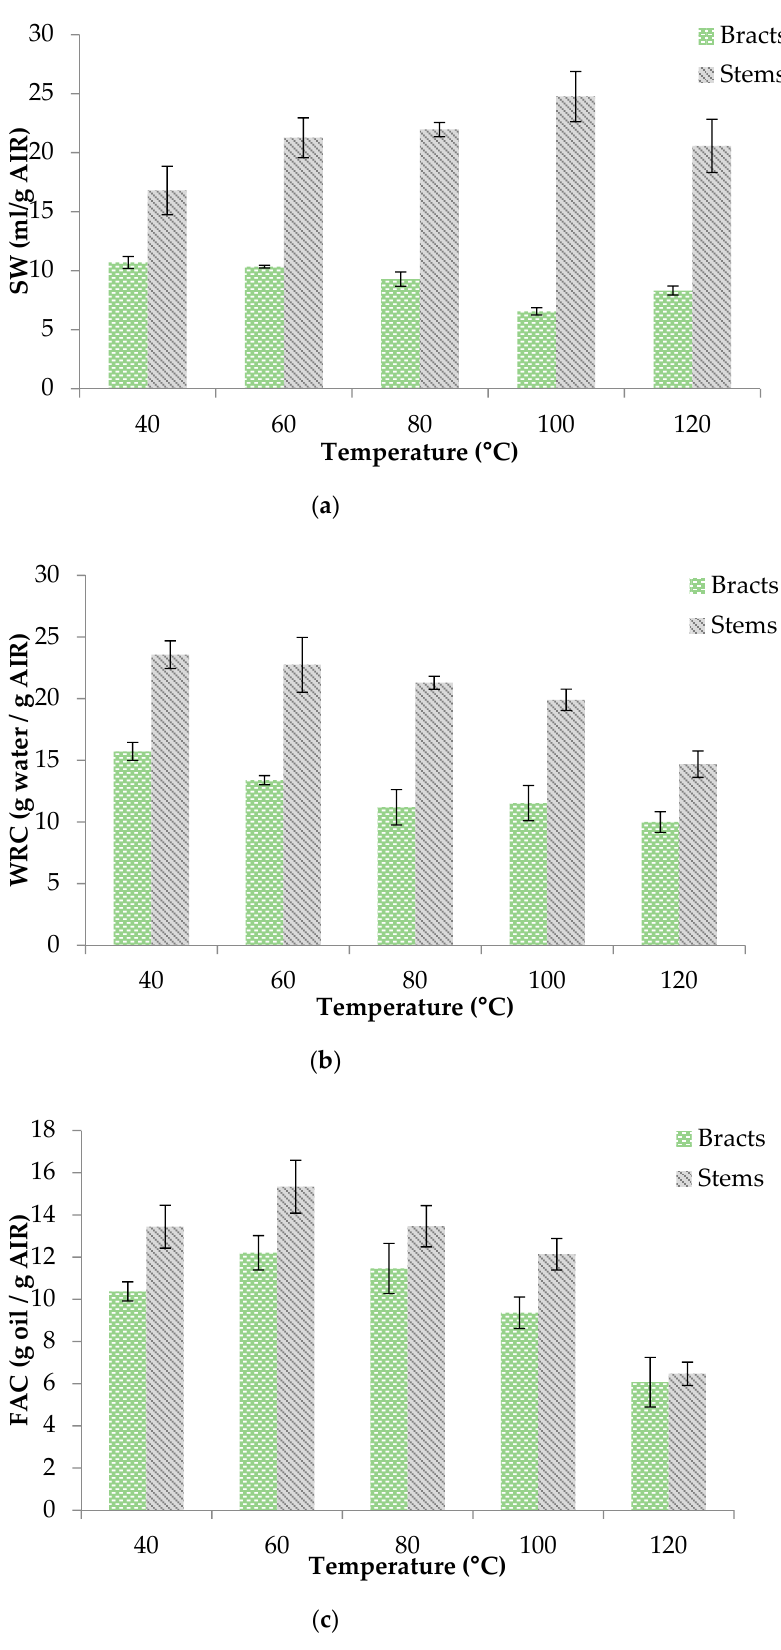
Figure 3. AIR functional properties of bracts and stems: ( a ) Swelling Capacity (SW); ( b ) Water Retention Capacity (WRC); ( c ) Fat Absorption Capacity (FAC).